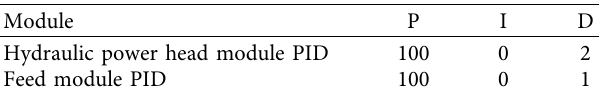
Table 2: PID parameters in the simulation